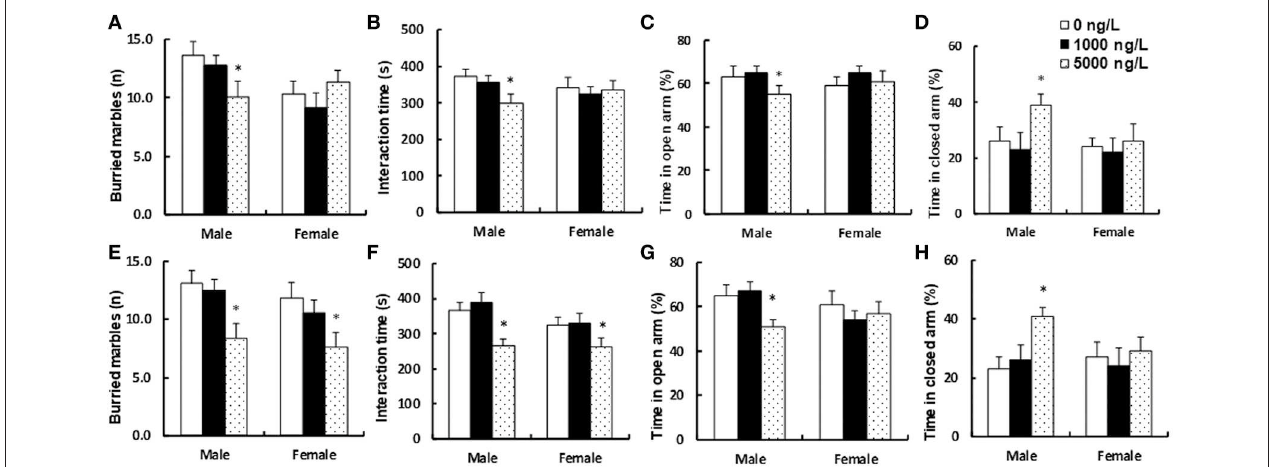
FIGURE 3 | Prenatal consumption of progestin-contaminated seafood induces autism-like behavior in offspring. Three months old pregnant dams were fed with progestin (P4 or NET)-contaminated seafood continuously for 21 days until pup delivery. Both male and female offspring were used for autism-like behavior tests at 10 weeks old. ( A–D ) Autism-like behavior tests for endogenous progestin (P4) treated offspring. (A) Buried marbles tests, n = 8. (B) Interaction time, n = 9. (C,D) Time spent in open (C) and closed (D) arms in EPM test, n = 8. (E–H) Autism-like behavior tests for synthetic progestin (NET) treated offspring. (E) Buried marbles tests, n = 9. (F) Interaction time, n = 9. (G,H) Time spent in open (G) and closed (H) arms in EPM test, n = 9, * P < 0.05, vs. 0 ng/L group. Results are expressed as mean ±